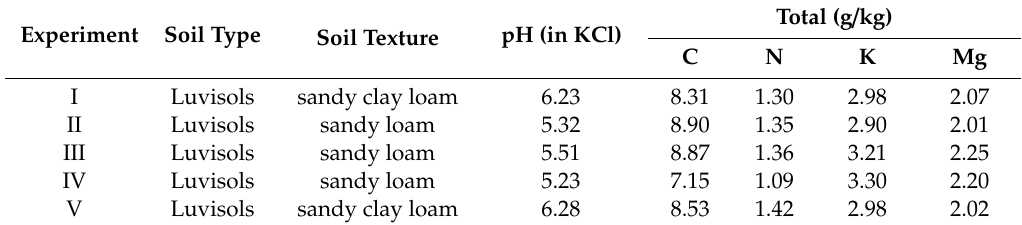
Table 3. Soil characteristics before the start of the experiments.